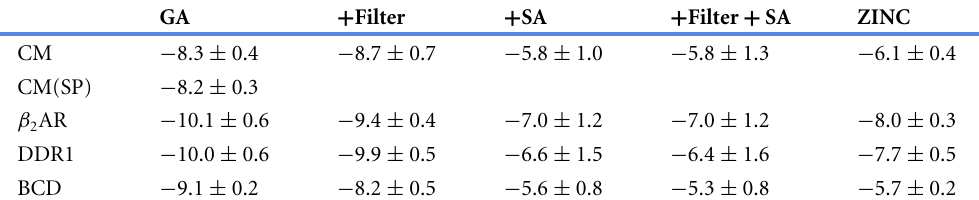
Table 3 The average docking score and standard deviation (in kcal/mol) of all the molecules in the combined final populations of 20 GA searches, except for ‘‘ZINC’’ which lists the corresponding values for the 8,000 top scoring molecules obtained using the 250 K ZINC subset. GA + Filter +